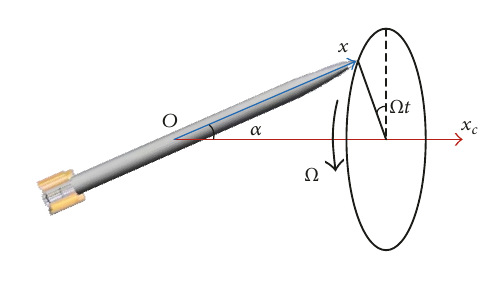
Figure 1: Coning motion of high dynamic